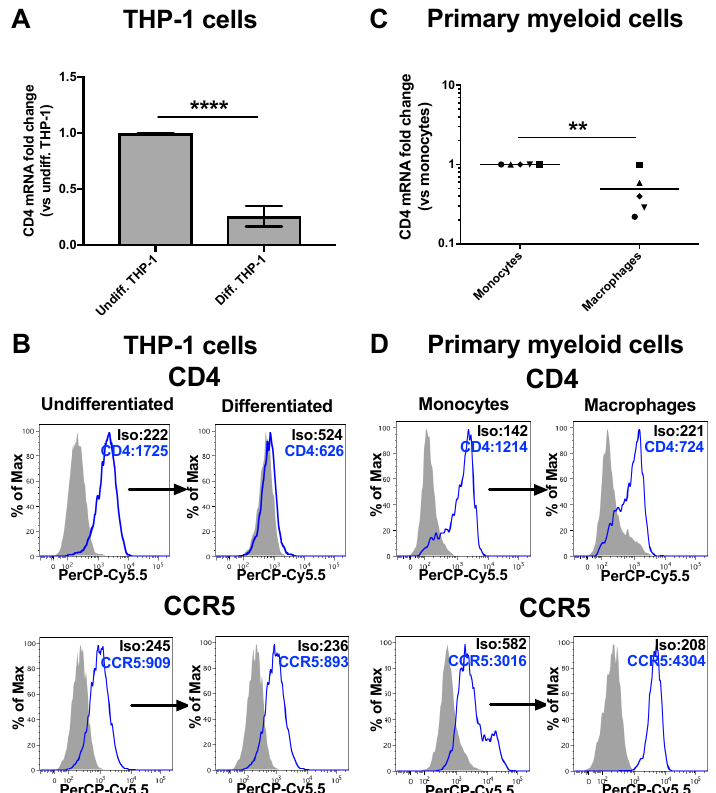
Figure 1. CD4 expression is reduced following differentiation of monocytes into macrophages. ** p < 0.01 and **** p < 0.0001. The levels of CD4 mRNA ( A : n = 12; means ± SD are shown and compared using Student’s t test), CD4 or CCR5 at the cell surface ( B : representative graphs are shown, n = 4) were compared in undifferentiated THP-1 cells or differentiated THP-1 cells following PMA treatment. Likewise, CD4 mRNA ( C : n = 5 blood donors; bars represent mean values which are compared using Mann-Whitney’s U test) or surface expression of CD4 or CCR5 ( D : representative graphs are shown of n = 4) were also measured in human primary monocytes and their corresponding derived macrophages (MDMs). Mean geometric fluorescence intensities (MFIs) are shown in the